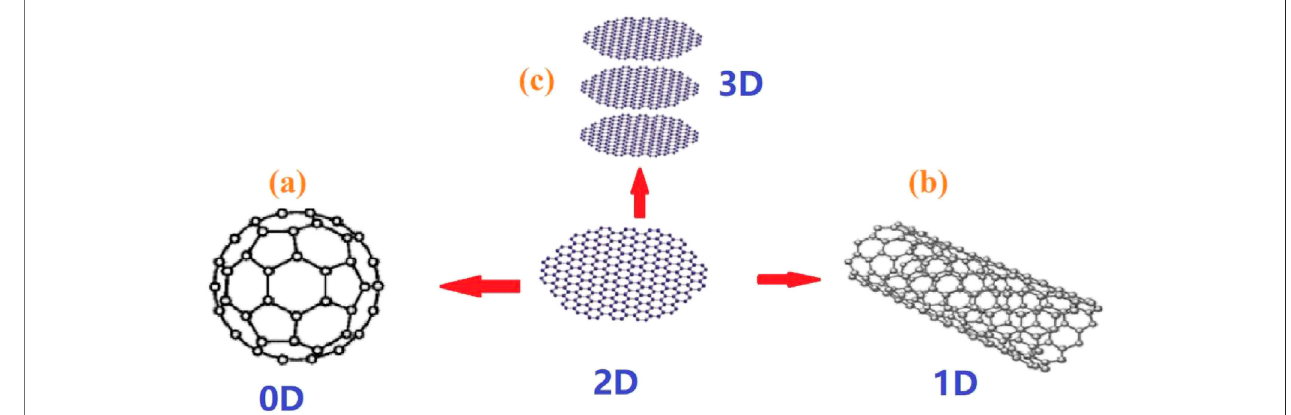
FIGURE 1 | Different forms of graphene.